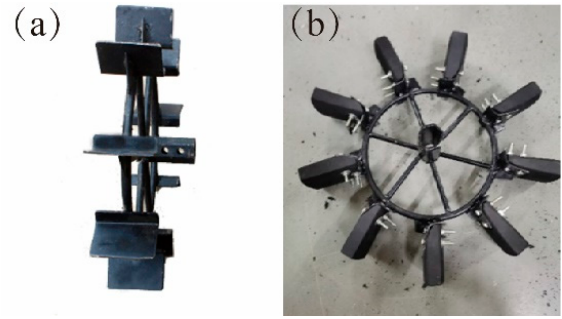
Figure 2. Test wheel. ( a ) Vaned wheel, ( b ) Bionic paddy wheel.